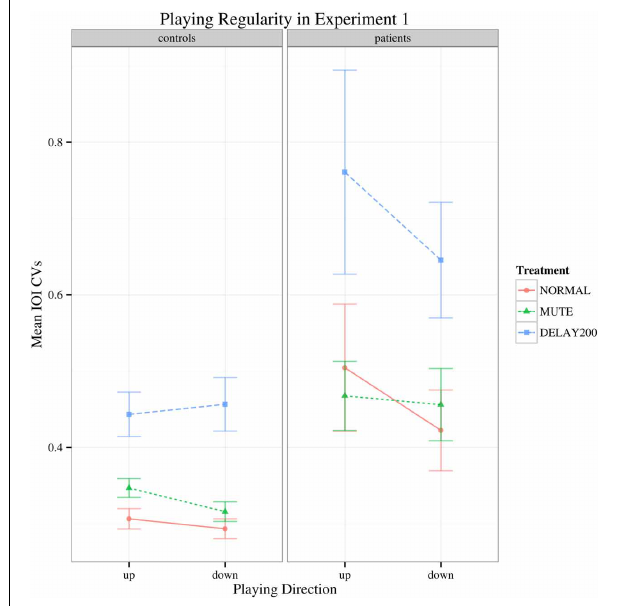
FIGURE 2 | Interaction plot of IOI CVs for Experiment 1. Error bars denote 95% confidence